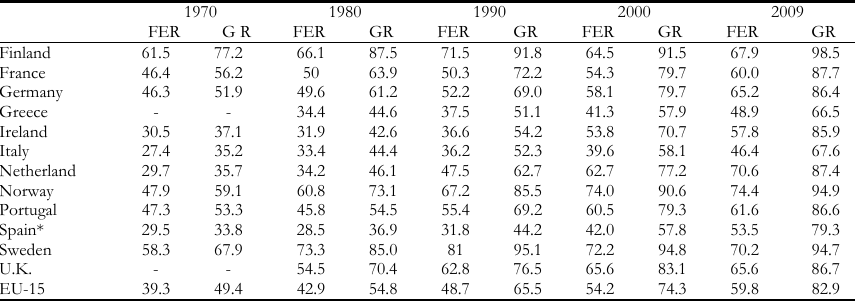
Female employment rate (FER) and gender ratio (GR) in employment rates. Selected European